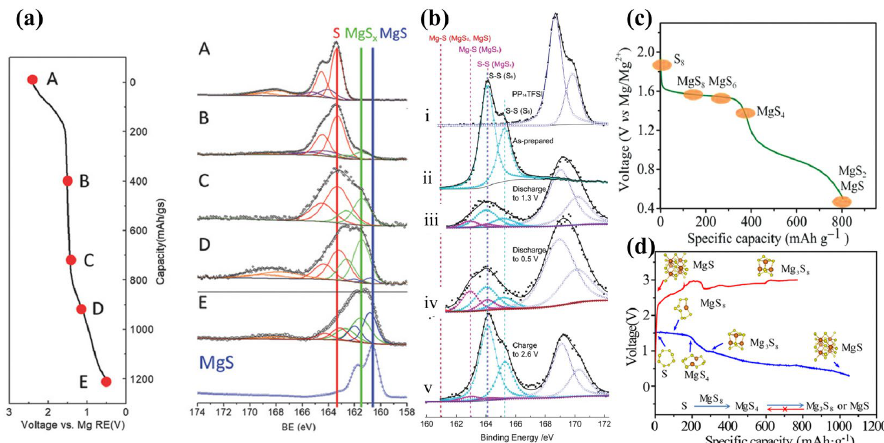
Figure 3. ( a ) XPS S 2p spectra of S/ACC cathode (S/C ratio = 0.11) at different states [18]. ( b ) XPS of S/CMK400PEG cathode and Mg(HMDS) 2 base electrolyte with ionic liquid PP14TFSI additives: (i) PP14TFSI, (ii) S/CMK400PEG, (iii) discharged to 1.3 V, (iv) discharged to 0.5 V, and (v) charged to 2.6 V, and ( c ) corresponding proposed mechanisms of discharge process [16]. ( d ) Charge − discharge curves and proposed mechanisms in Mg(HMDS) 2 − based electrolyte [19].